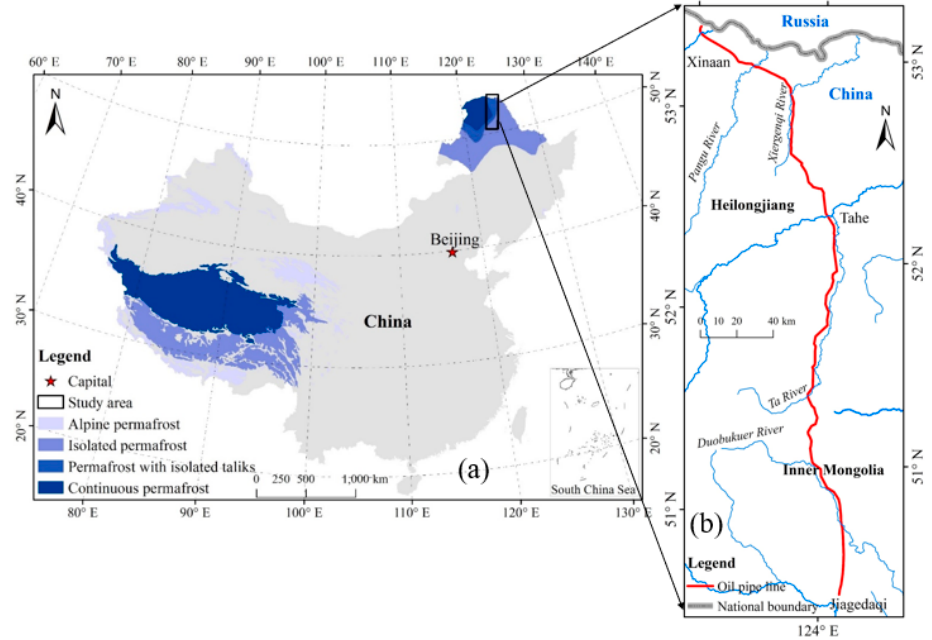
Figure 1. Location of the study region (from [19], the reference system is Krasovsky 1940 Albers), (a) permafrost distribution in China, (b) pipeline location from Xing’an to Jiagedaqi. Table 1. Band information of the Landsat 8 Operational Land Imager (OLI) images.